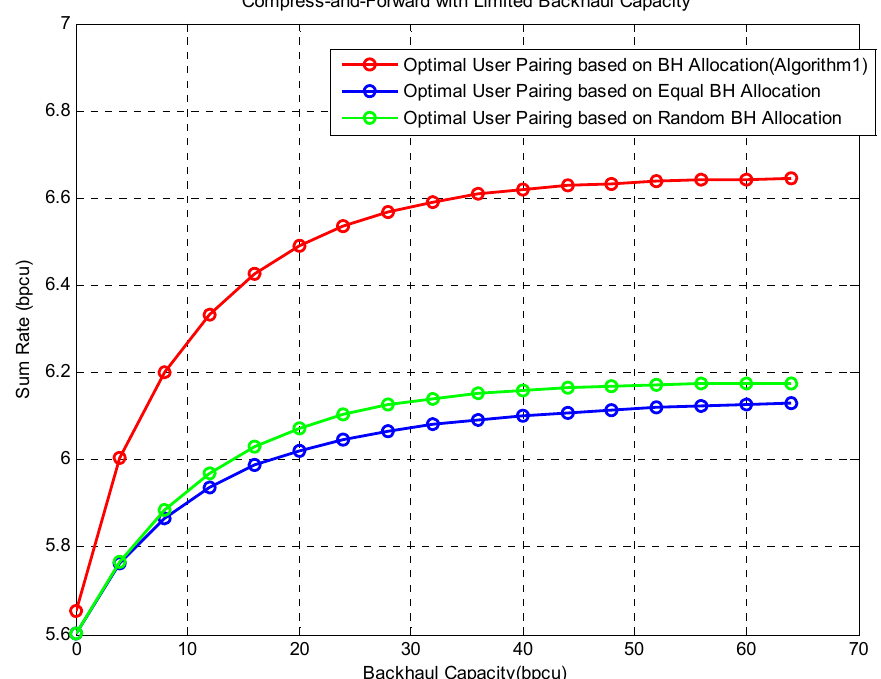
Figure 3. Comparison of different methods. The red curve is our proposed optimal method, the green one is the method using equal backhaul resource allocation and the blue one is the performance of random resource allocation.